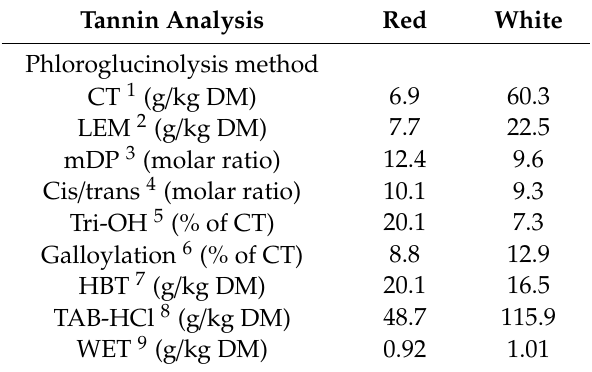
Table 2. Concentrations of tannins in red grape marc (Red) and white grape marc (White).